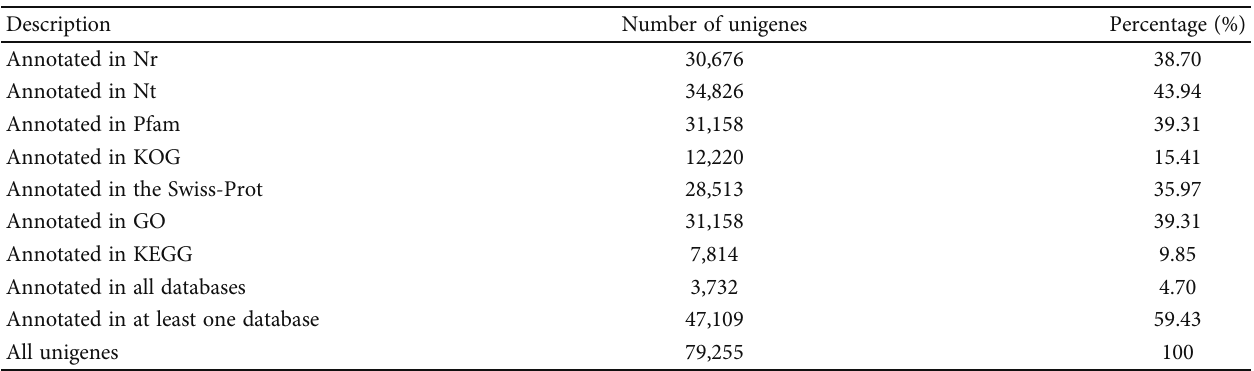
Table 4: Summary of annotation results of the muscular